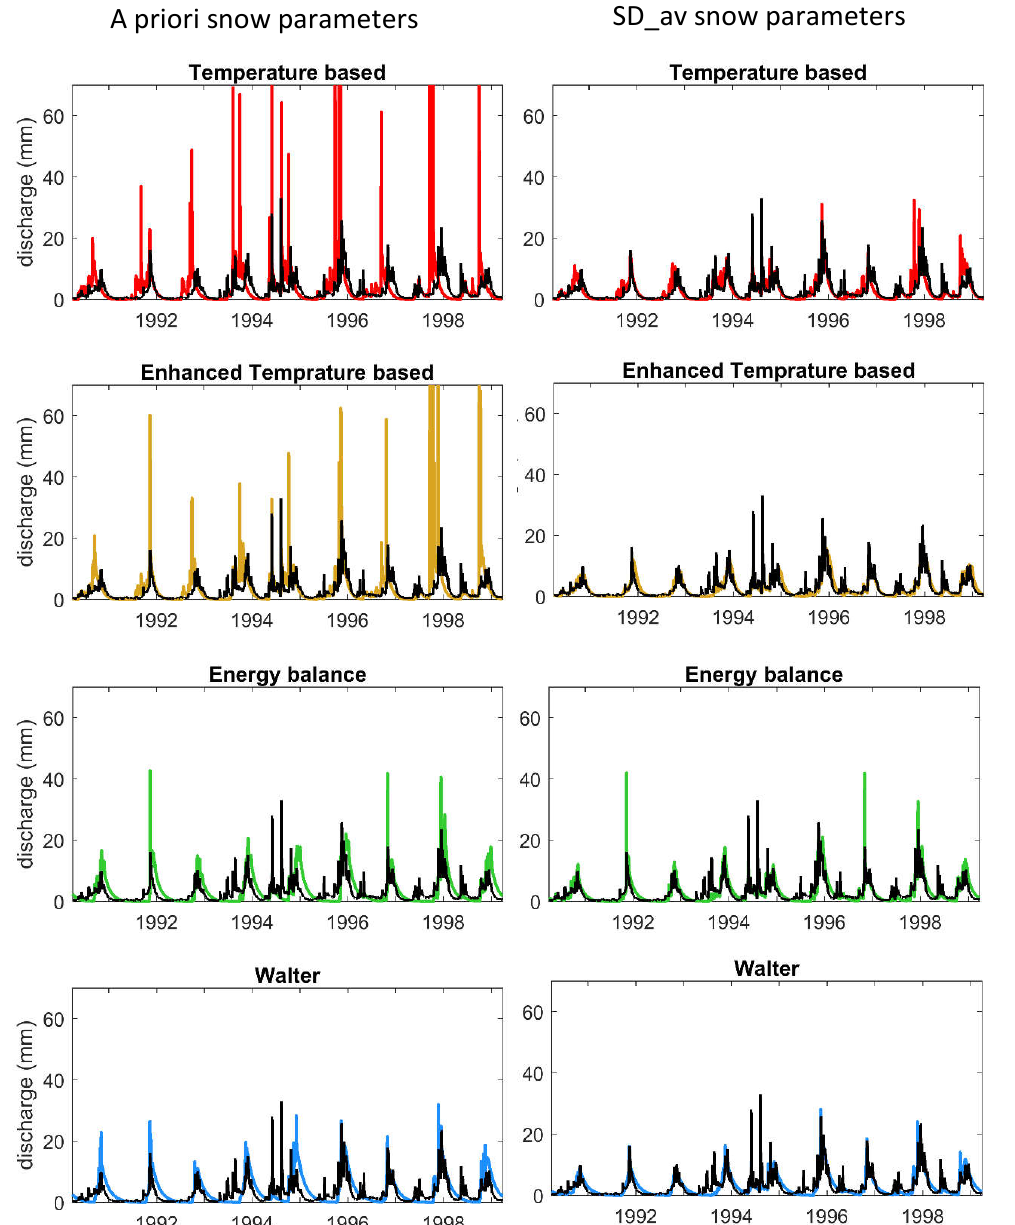
Figure 7. Hydrographs for all snow models with SCE calibrated soil parameters for catchment 12488500 which has 62% of precipitation falling as snow. The plots on the left use a priori estimated snow parameters; on the right, the snow models use the parameters estimated with SNODAS using the average daily temperature